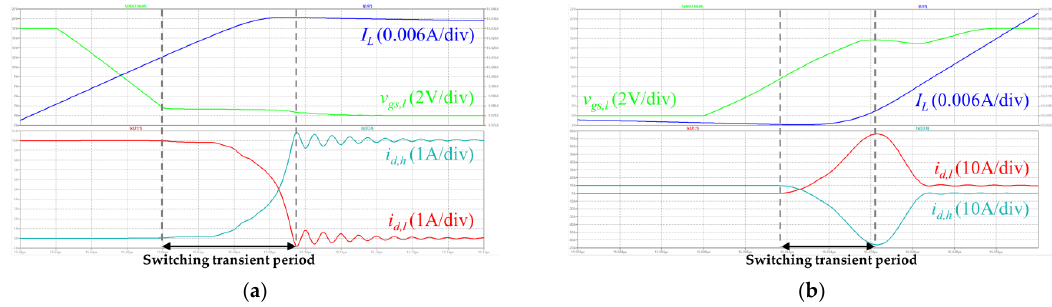
Figure 17. Switching transient waveform. ( a ) Turn-on. ( b ) Turn-off.